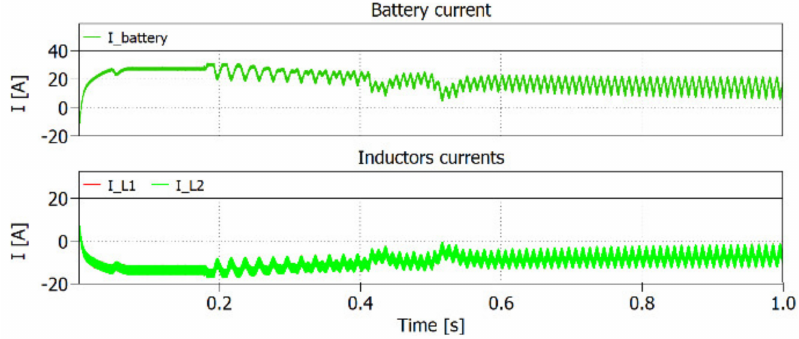
Figure 19. Battery and Bi-BB converter inductor currents for Scenario 1.